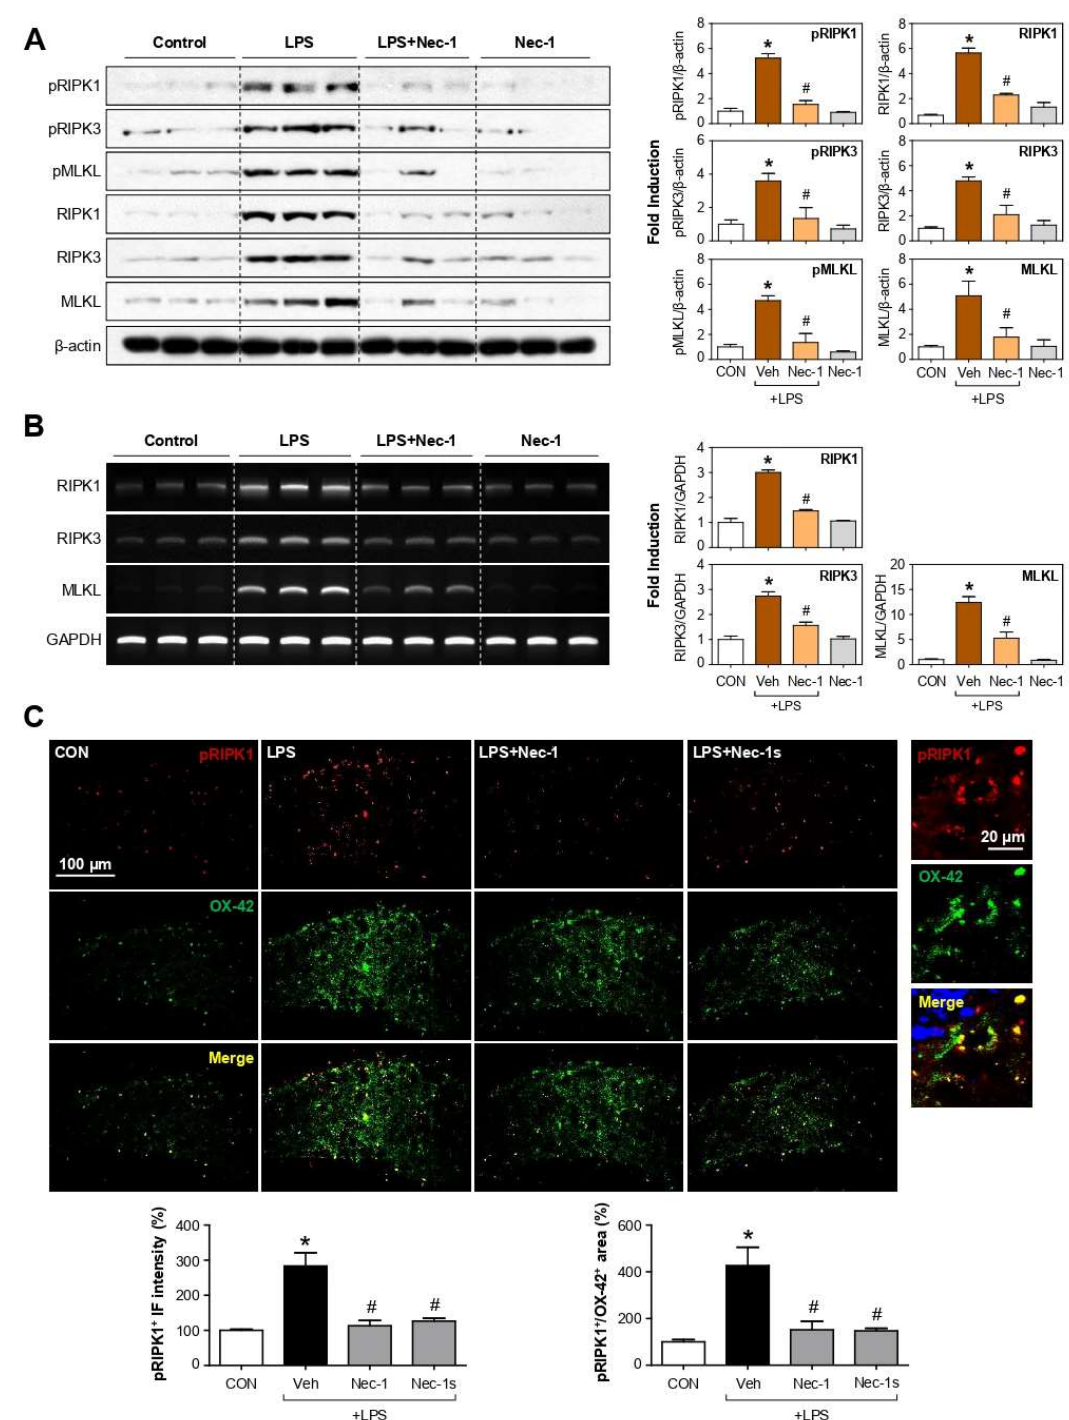
Figure 6. Effects of Nec-1 on protein and mRNA expression of necroptosis markers in the brains of LPS-injected mice. ( A ) Western blot analysis using antibodies against the phospho- or total forms of RIPK1, RIPK3, and MLKL in the cortex of LPS-injected mice. ( B ) RT-PCR was performed to measure the expression of RIPK1, RIPK3, and MLKL mRNA. Representative gels are shown in the left panel and quantifications in the right panel. ( C ) Double immunofluorescence (IF) staining for p-RIPK1 ser166 (red, auto-phosphorylated RIPK1 marker) and OX-42 (green, microglial marker) in DG of LPS-injected mice. Representative images are shown. Quantification of the p-RIPK1 positive intensity (%) is shown in the left panel, and p-RIPK1/OX-42 positive colocalization (%) is shown in the right panel. Data are shown as the mean ± SEM. * p < 0.05 vs. control group; # p < 0.05 vs. LPS